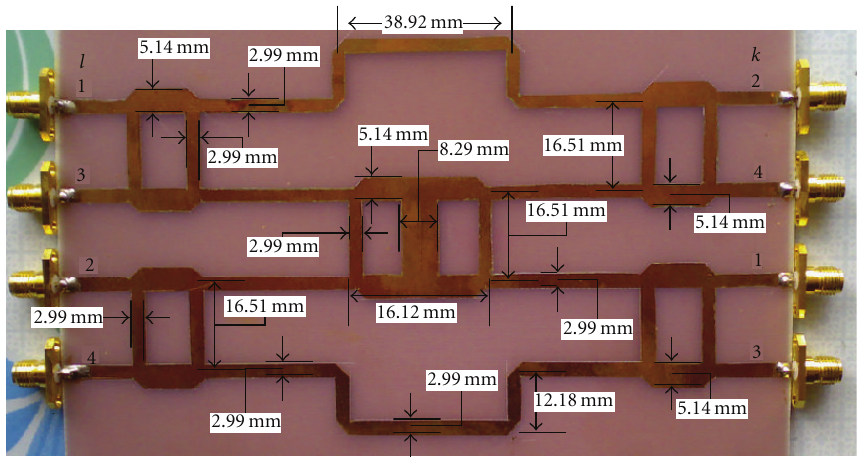
Figure 4: Configuration of manufactured Butler matrix.